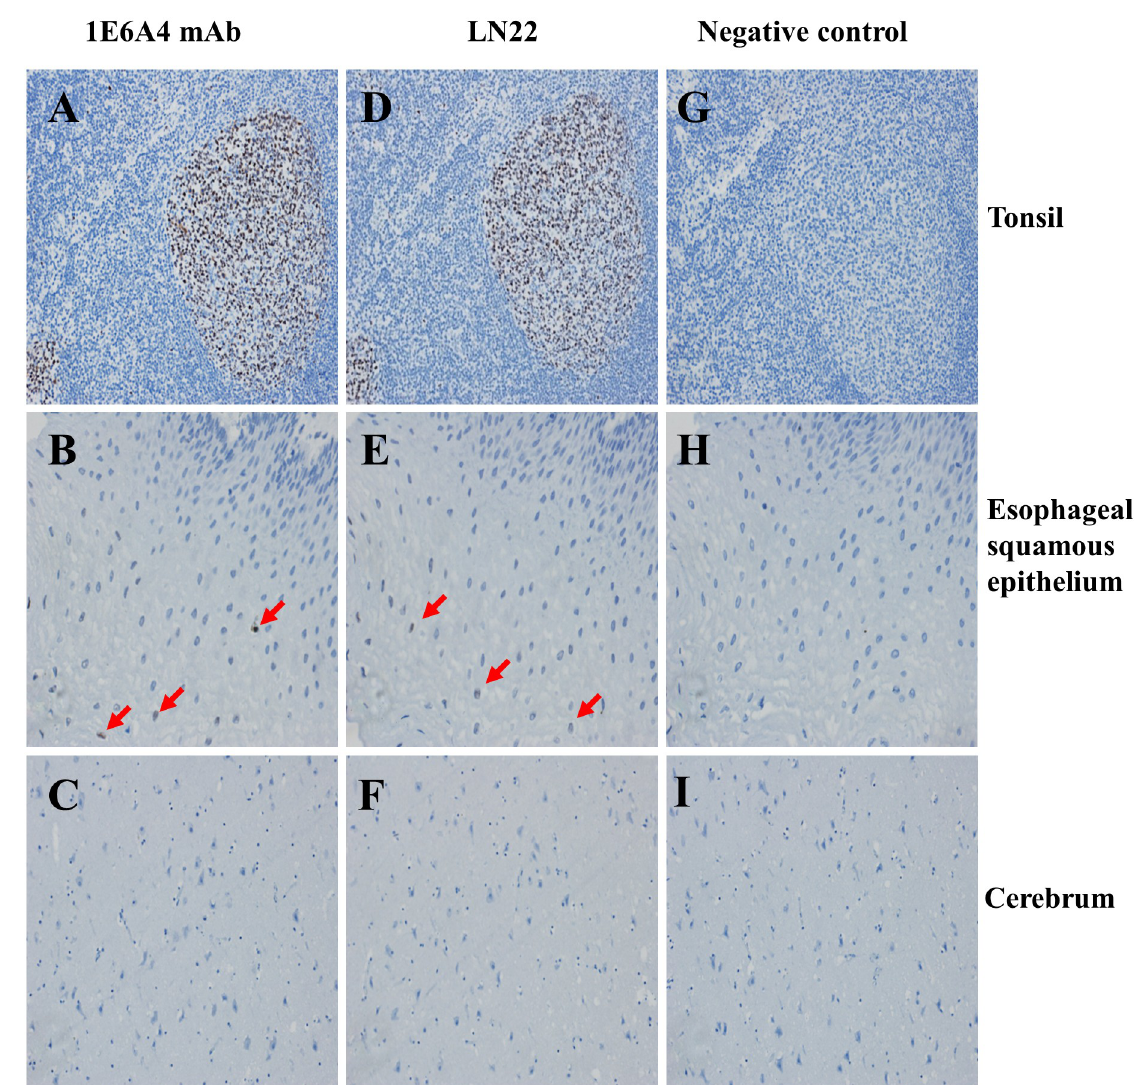
Fig 6. The immunohistochemistry tests of 1E6A4 mAb in difference tissues. The immunohistochemistry tests of 1E6A4 mAb was determined in tonsil (A) ( × 200), esophageal squamous epithelium (B)( × 400), and cerebrum (C) ( × 200). The images (D), (E) and (F) showed the staining of LN22 antibody for corresponding tissues, as positive control. The images of (G), (H) and (I) showed the staining of IgG control antibody for corresponding tissues, as negative control. The cells reactive with antibodies were stained with brown color. Some stained cells were indicated with